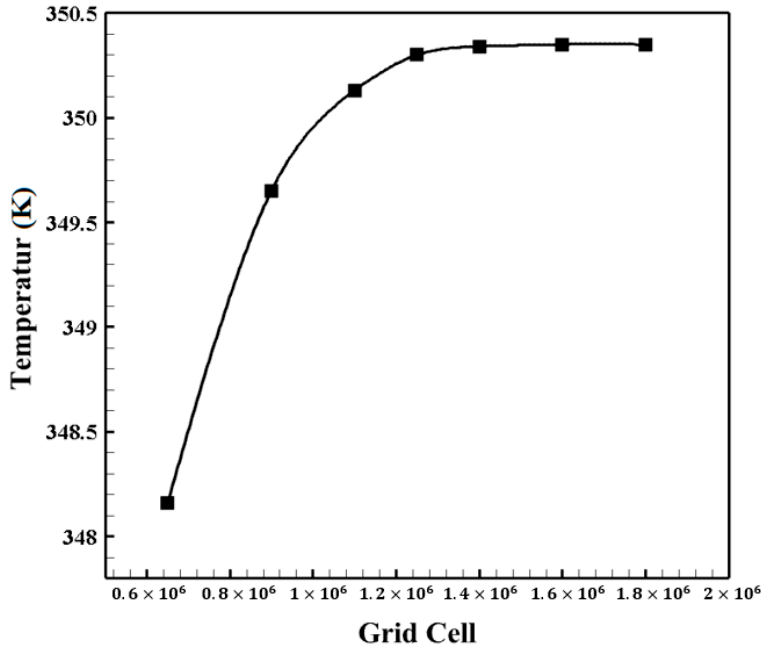
Figure 6. The obtained results of the mesh independence analysis.